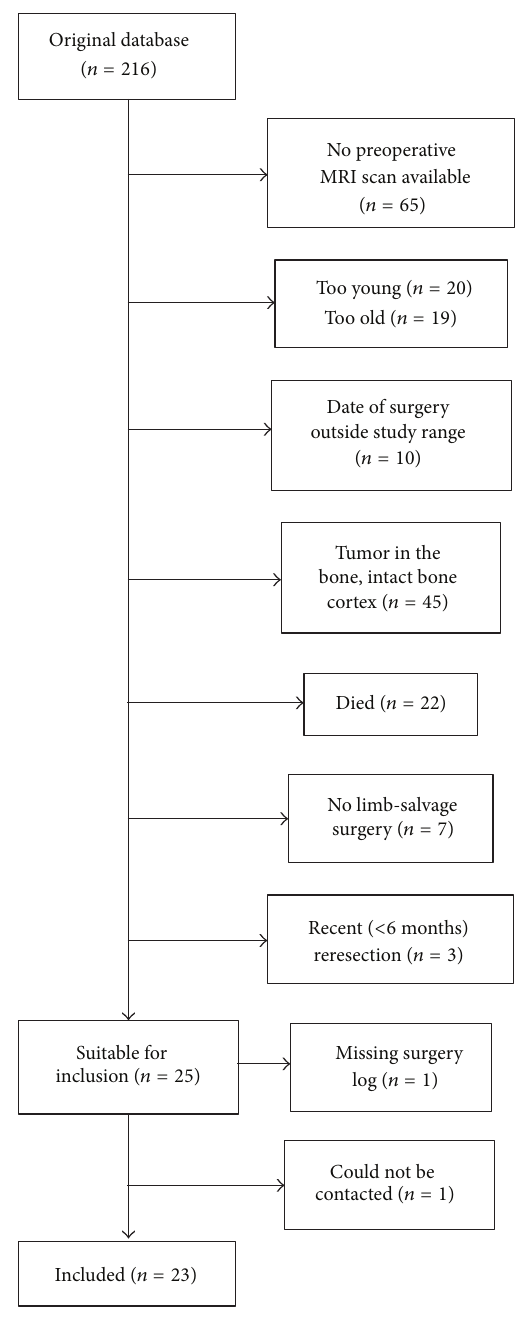
Figure 1: Flow chart of patient selection. Some patients fitted into multiple exclusion criteria (e.g., “no preoperative MRI scan avail- able”and“tooold”);insuchcases,thepatientwascountedasbelong- ing to the first of those exclusion